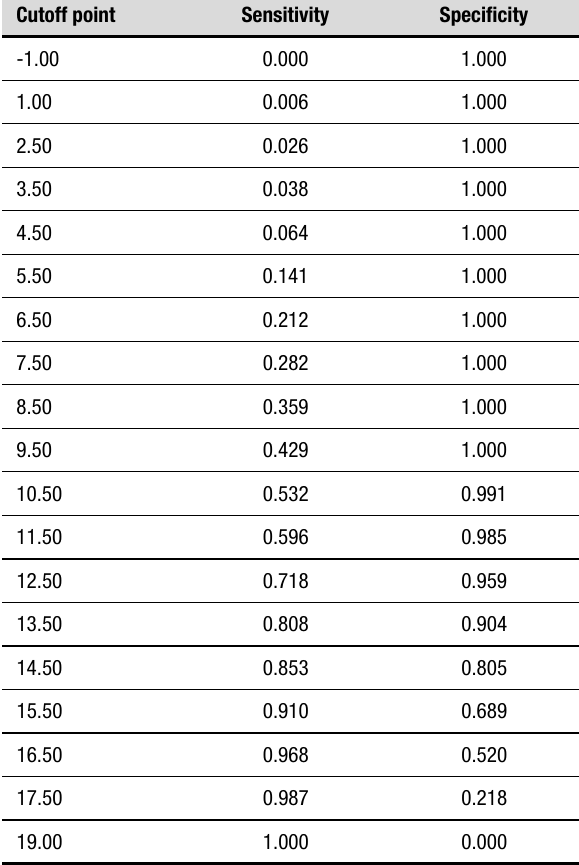
Table 3. Sensitivity and specificity of the Chilean version of the Frontal Assessment Battery for the discrimination of dementia patients (n=156) and healthy controls (n=344) in the complete sample. Cutoff point